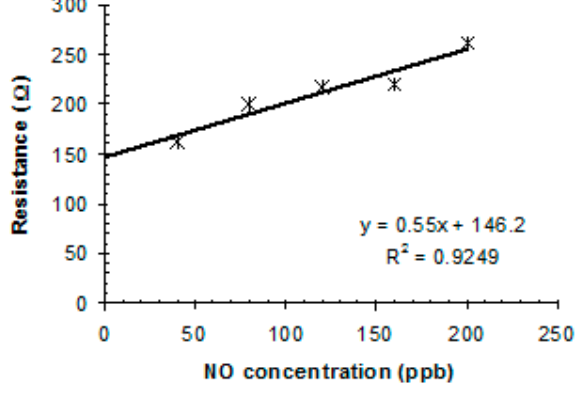
Figure 7. Linear fitting of sensor response toward ppb-level of NO gas.